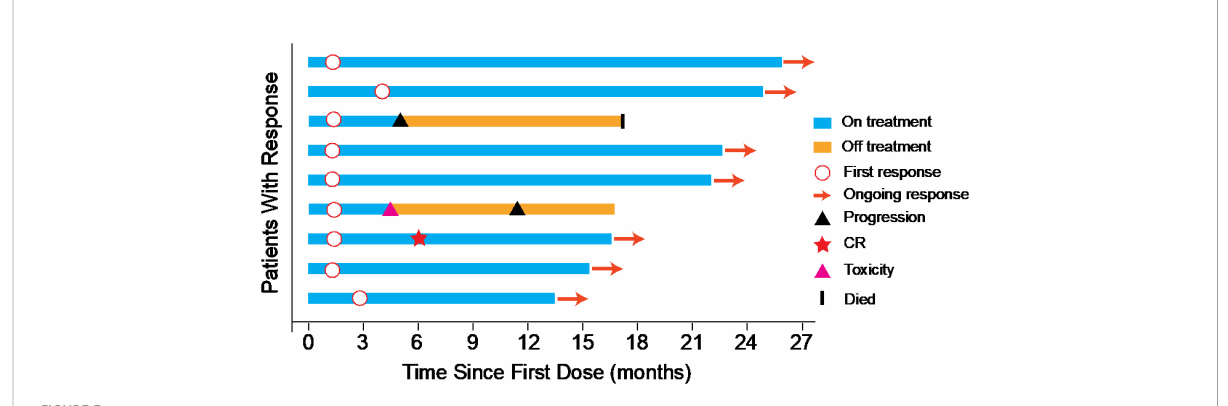
FIGURE 3 Duration of response for patients with PR and CR.